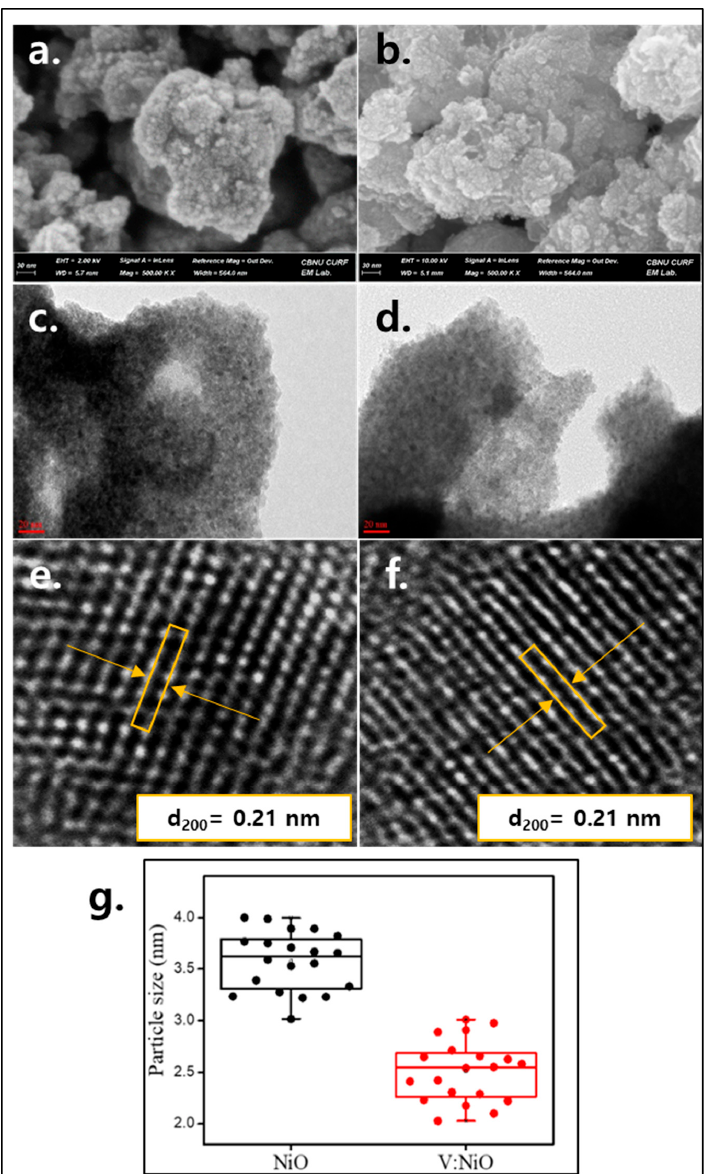
Figure 4. (a) FESEM images of ( a ) NiO and ( b ) 3 at.%V:NiO and TEM patterns of ( c ) NiO and ( d ) 3 at.%V:NiO. ( e , f ) HRTEM images of both ( e ) NiO and ( f ) 3 at.%V:NiO and ( g ) statistics of the particle distributions of NiO and 3 at.%V:NiO